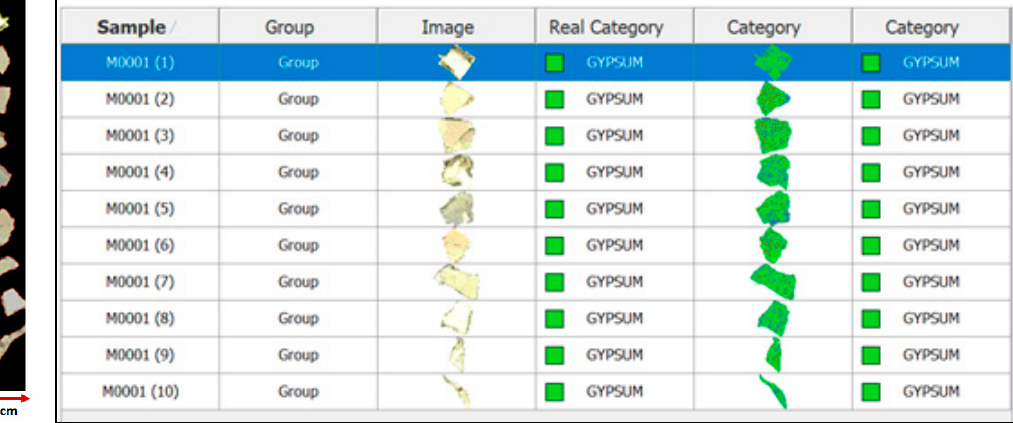
Figure 5. Example of validation trial showing a picture of scanned samples and table of classifications carried out by the PLS-DA model (real category vs. predicted category). Note that plasterboard was defined as ‘GYPSUM’ in the model software.